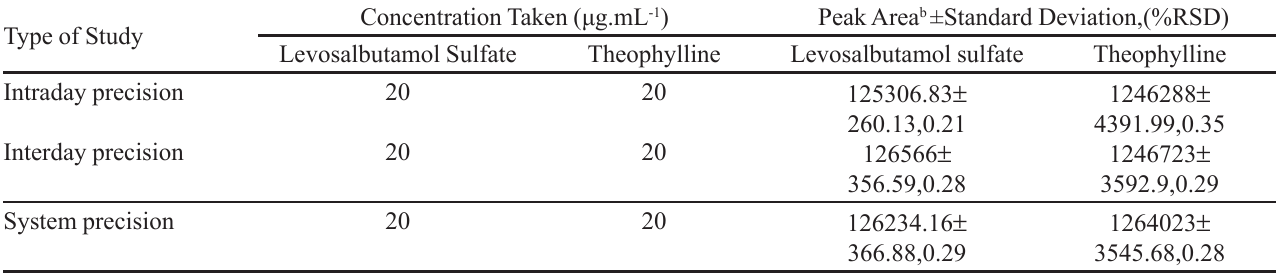
TABLE II - Intraday, interday and system precision studies(n=6)